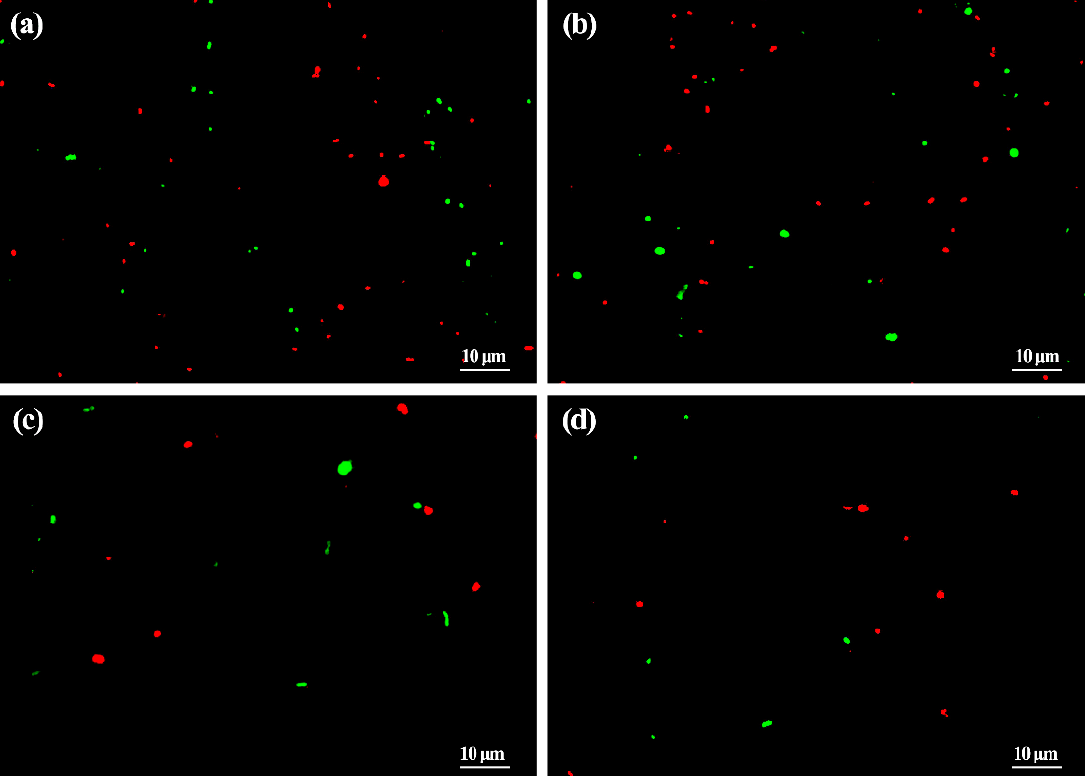
Figure 2. Antibacterial effect of ZnONP at the final density of 20 µg/mL on gut bacteria by living and dead cell staining: ( a ) healthy children; ( b ) healthy children + ZnONP; ( c ) ASD children; ( d ) ASD children + ZnONP.